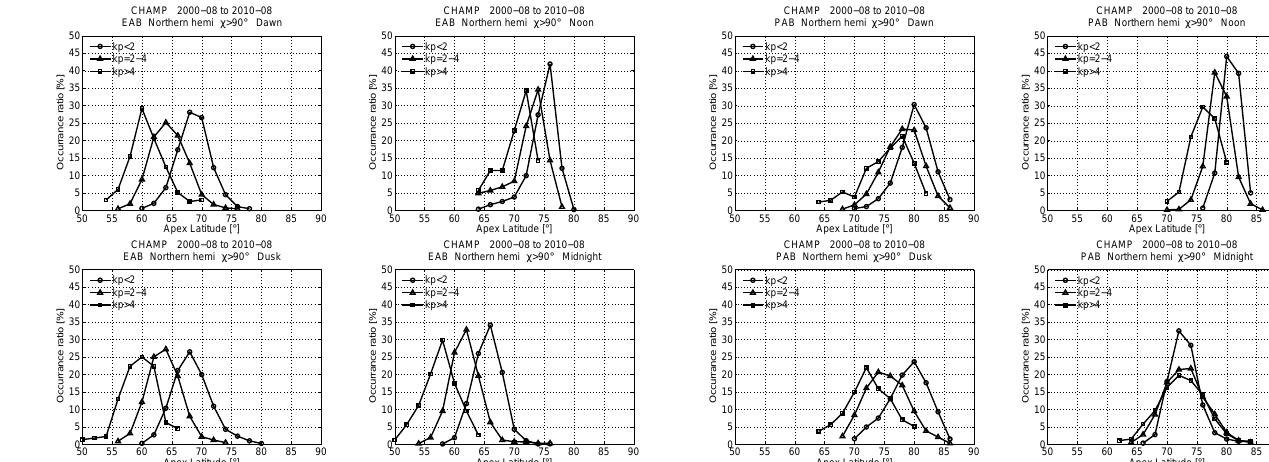
Fig.5. ActivitydependenceoftheequatorwardauroralboundarylatitudedistributionfordifferentMLTsectors: dawn (top left), noon (top right), dusk (bottom left), midnight (bottom right).